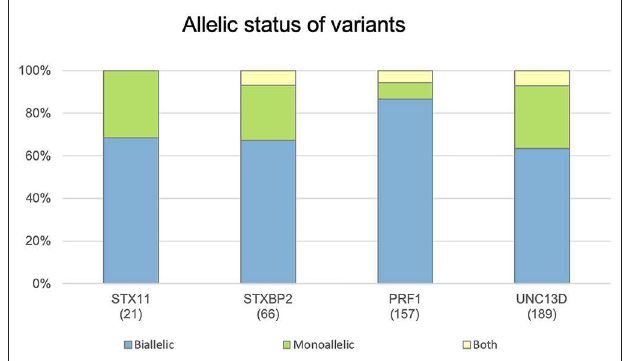
FIGURE 3 | Distribution of genetic variants according their allelic status. Histograms show the distribution of variants in the STX11, STXBP2, PRF1, and UNC13D genes included in FHLdb. The total number of variants reported in each gene is indicated within parentheses.